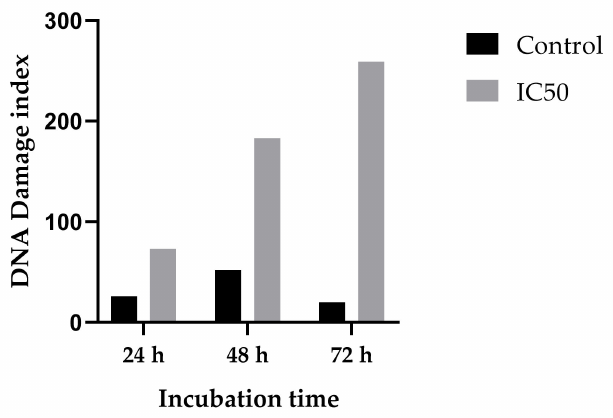
Figure 12. Genotoxic effect of 3 after incubation with the AGS cell line at 50 µ M concentration. DNA damage index was calculated based on comet assay results. As a control, a medium with 1% DMSO was